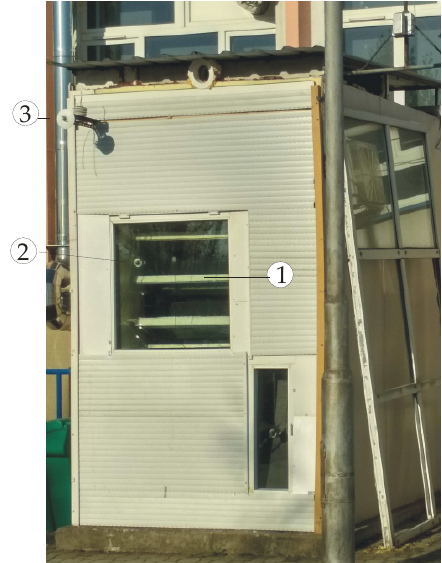
Figure 5. The chamber for field tests: 1—IGW module, 2—pyranometer (I g ) placed behind the exterior glazing, 3—pyranometer (I e ) placed outside the chamber.